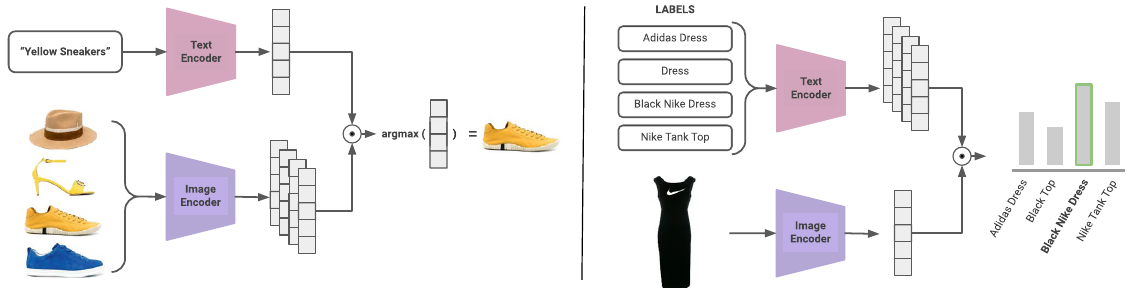
Figure 2. Schematic overview of multi-modal retrieval (left) and zero-shot classification tasks